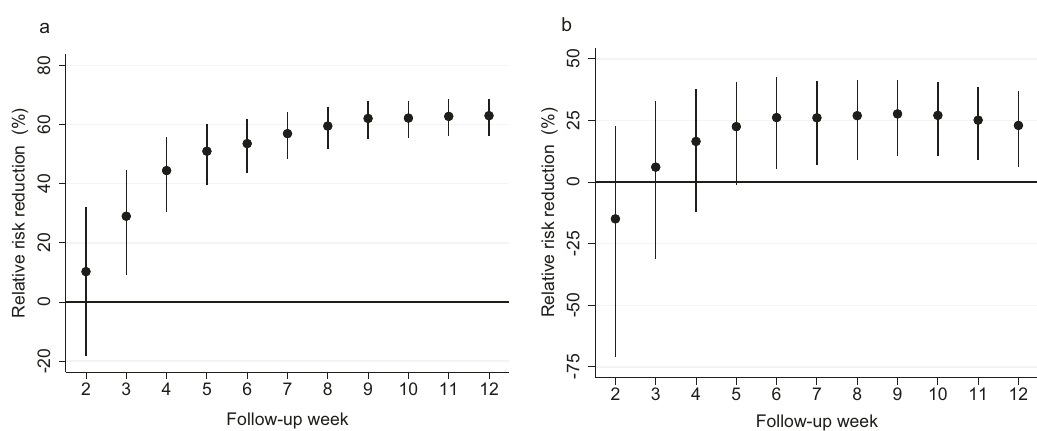
Fig. 1 Vaccine effectiveness in vaccinated healthcare workers and their unvaccinated partners living in the same household. This fi gure plots vaccine effectiveness estimates by week after the fi rst dose of mRNA-based vaccination. The dependent variable is a polymerase chain reaction (PCR)-con fi rmed SARS- CoV-2 infection as recorded in the Finnish National Infectious Diseases Register. a Direct effectiveness estimates (relative risk reduction) for vaccinated individuals compared to the control group, which is constructed by randomly assigning the beginning of a follow-up period for unvaccinated individuals. N = 265,326 healthcare worker observations. b Indirect effectiveness estimates (relative risk reduction) for the unvaccinated partners (including cohabiting partners) of vaccinated individuals who lived in the same household as the vaccinated person as of December 31, 2019. N = 128,952 partner observations. The coef fi cients in both panels are estimated using a log-binomial regression model and individual-date data collapsed to individual-week data. See section Methods, Estimation samples, for details of the sample restrictions and estimation method. The relative risk reduction is presented as a percentage in data points ±95% con fi dence intervals. The solid black dots show relative risk reduction by week after receiving the fi rst dose of mRNA-based vaccination. The error bars denote the 95% con fi dence intervals clustered at the individual level using endpoint transformation of the originally estimated con fi dence